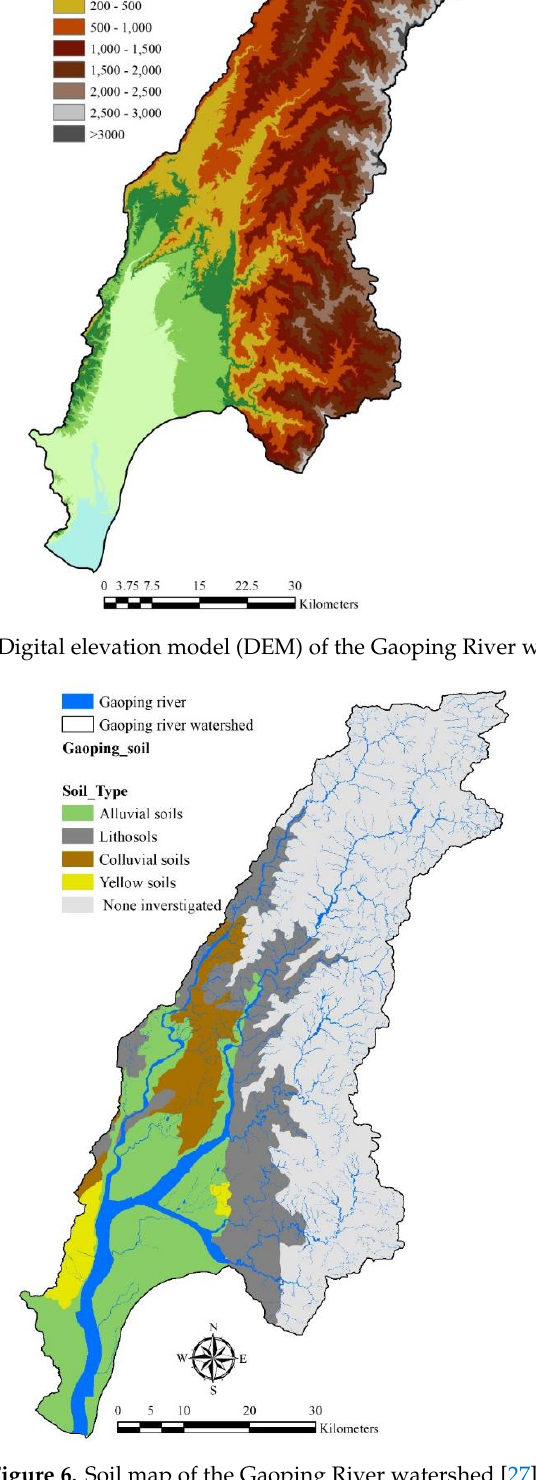
Figure 6. Soil map of the Gaoping River watershed [27].